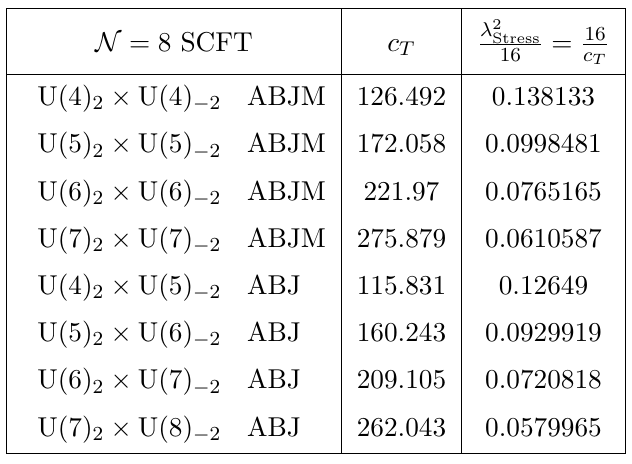
Table 4 . Several values of c T and λ 2 the all orders in 1 /N formulae in